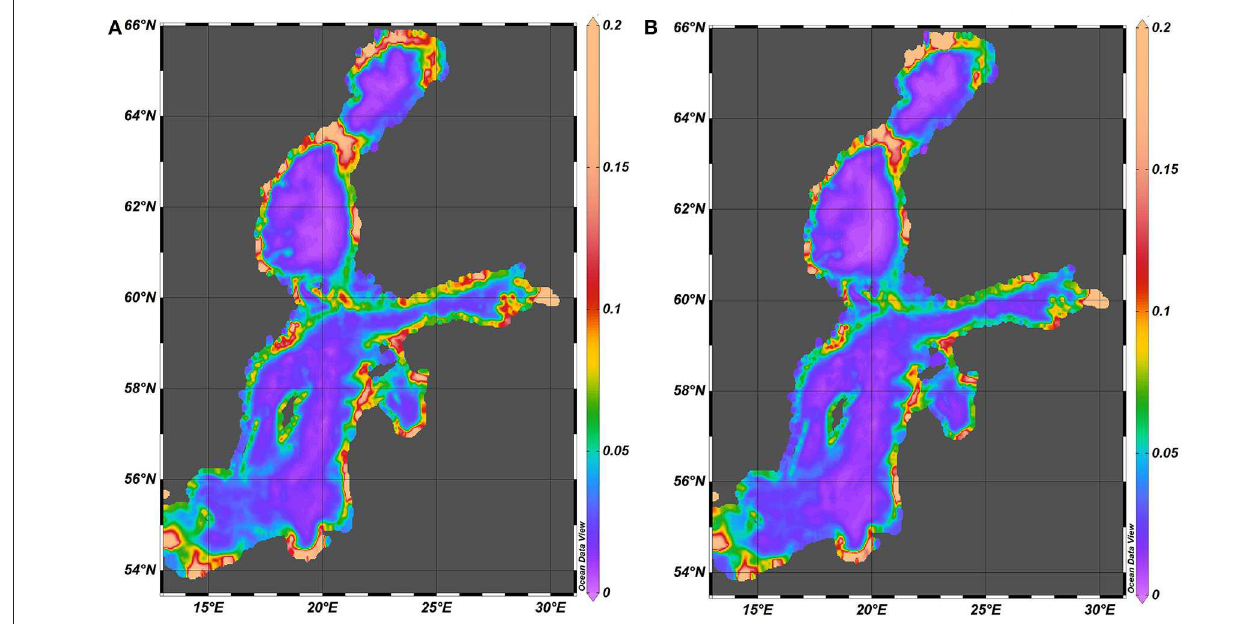
FIGURE 11 | Spatial distribution of the normalized (1 / H 2 ) potential energy spectral amplitude (kg · s − 2 · m − 2 ) in 1961–1965 (A) and 2000–2005 (B) .